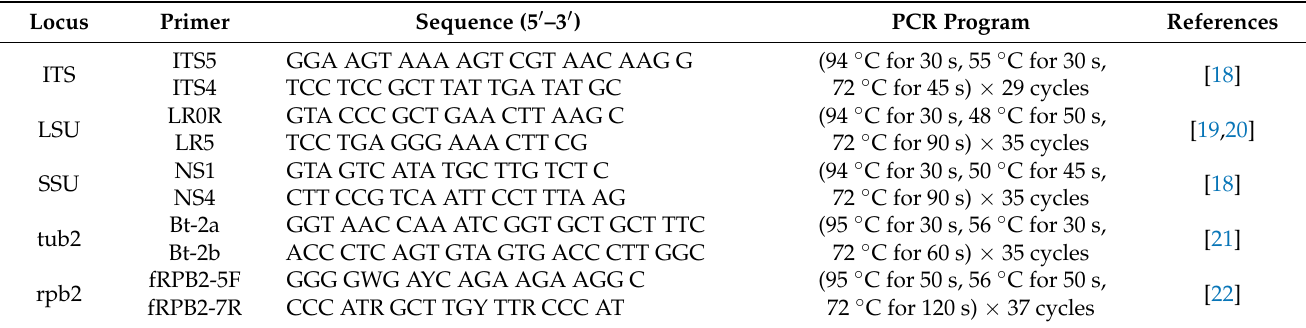
Table 1. Gene regions, respective primer pairs, and PCR programs used in the study.